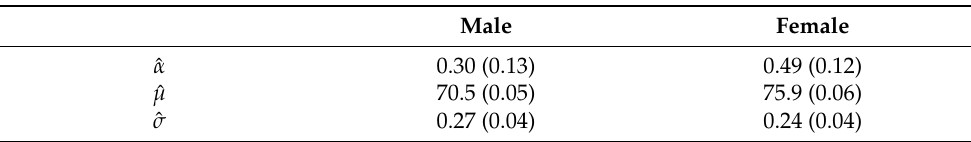
Table 1. Estimated parameter values of a fitted Gumbel autoregressive model of order one—Gumbel AR(1) with estimated asymptotic standard errors.